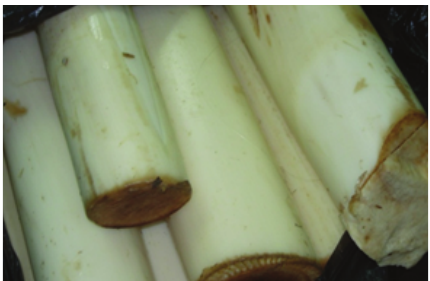
Figure 1: Pith of banana stem after separated with foliage.